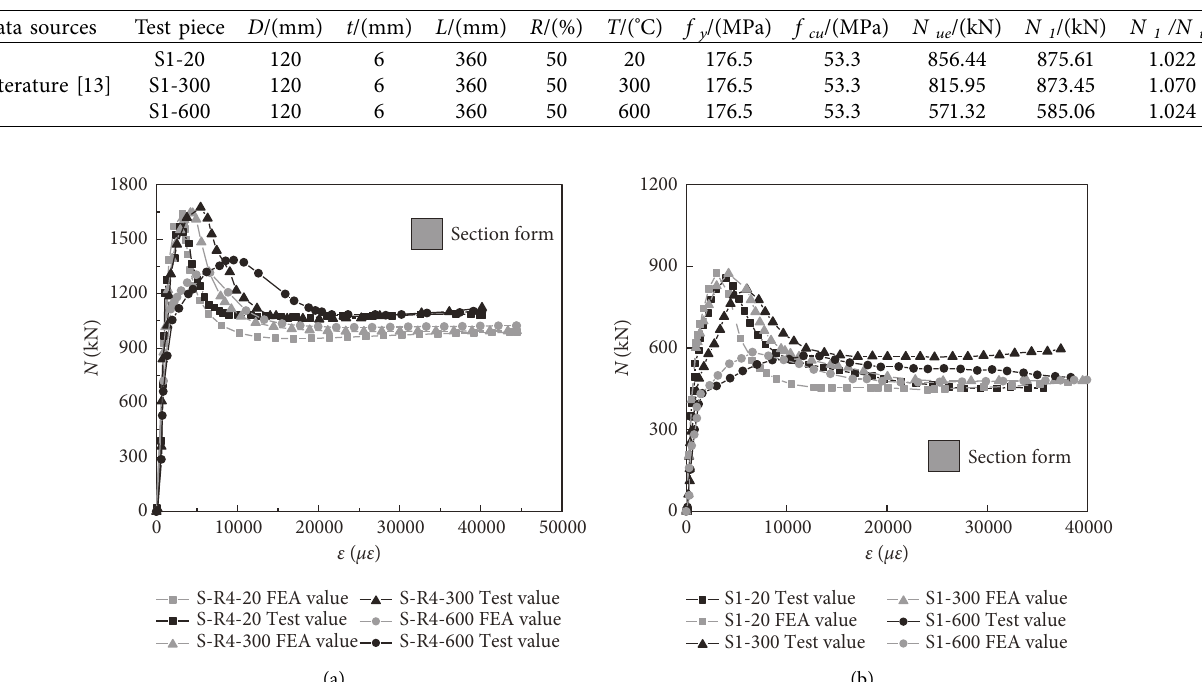
Figure 5: Comparison of test curve with FEA in this paper. (a) Comparison between the test in this paper and FEA results. (b) Comparison of test in reference [13] and FEA